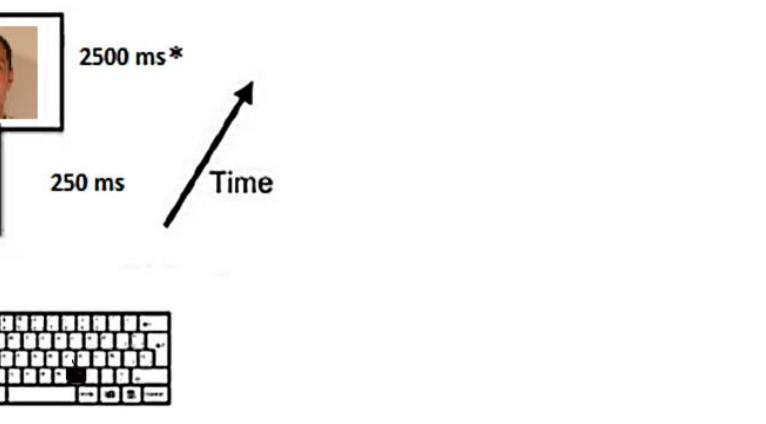
Figure 1. Task displays and trial structure for the matching task*. Each stimulus had a maximum duration for recognition of 2500 ms*. A simulation of KDEF images was employed because of cop- yright